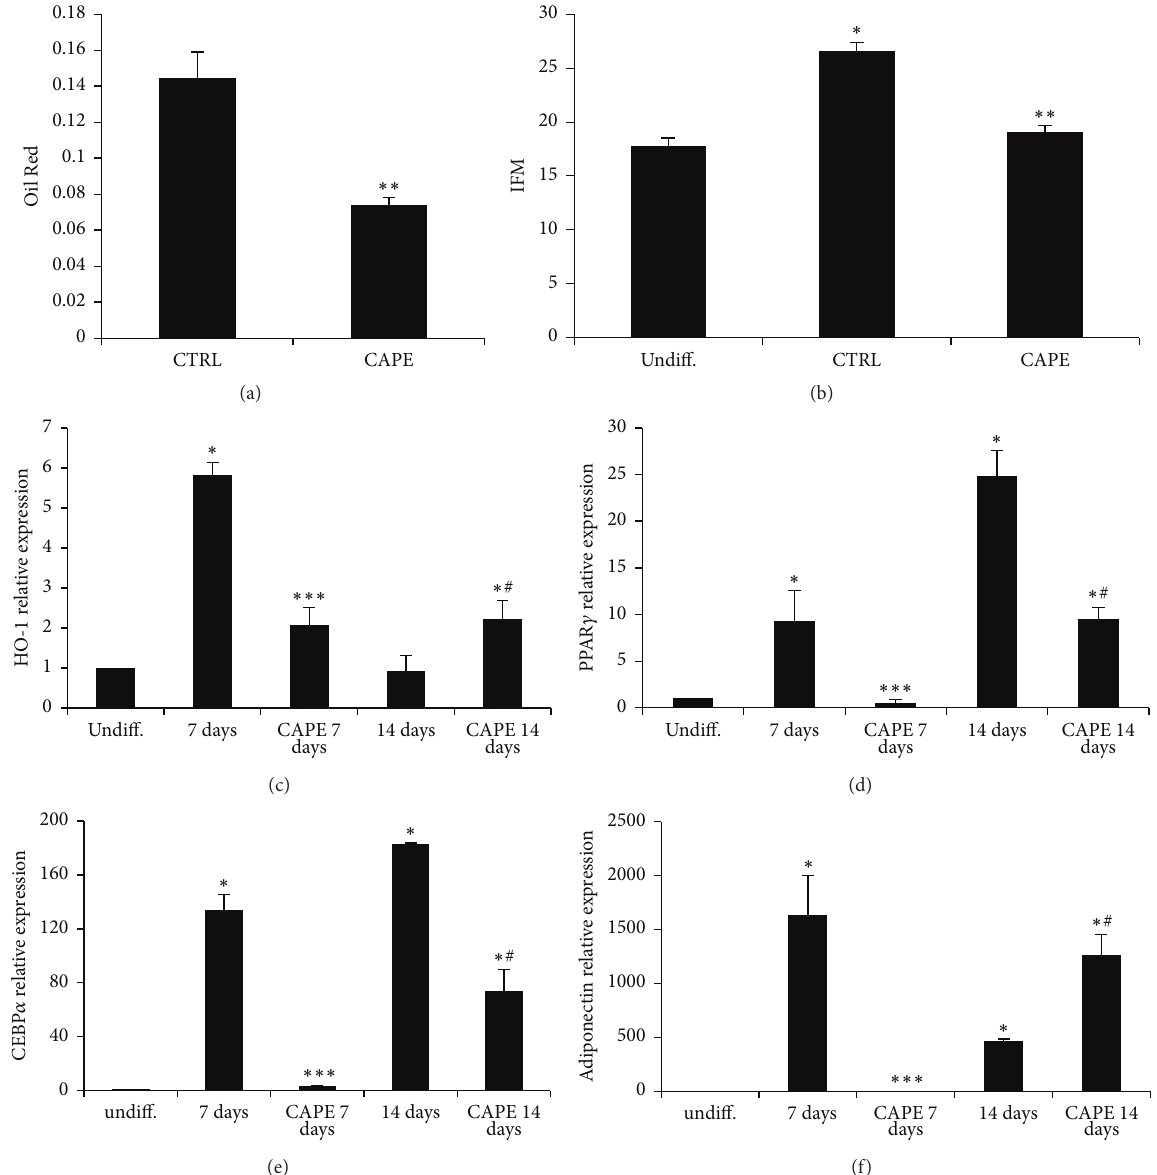
Figure 4: The effect of Cape on differentiation. (a) Lipid droplets area was determined by Oil red O staining after 14 days. (b) Intracellular oxidants in undifferentiated, differentiated untreated, and treated cells for 14 days with Cape (10 𝜇 M). (c–f) Effect of Cape on HO-1 PPAR 𝛾 , CEBP 𝛼 , and adiponectin mRNA levels after 7 and 14 days of differentiation. Values represent the means ± SD of 4 experiments performed in triplicate. ∗ 𝑝 < 0.05 , significant result versus undifferentiated cells. ∗∗ 𝑝 < 0.05 , significant result versus control cells. ∗∗∗ 𝑝 < 0.05 , significant result versus 7 days. # 𝑝 < 0.05 , significant result versus 14